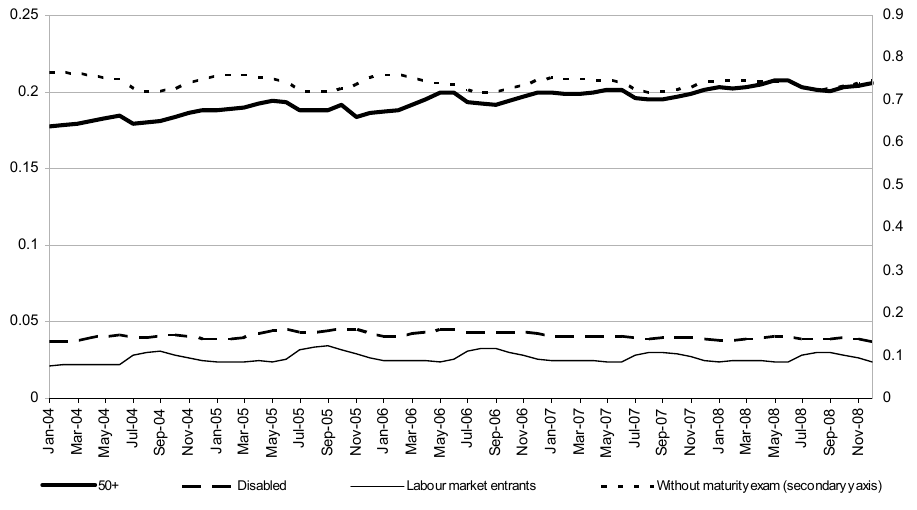
Figure 2: Average composition of the local PES offices between January 2004 and December